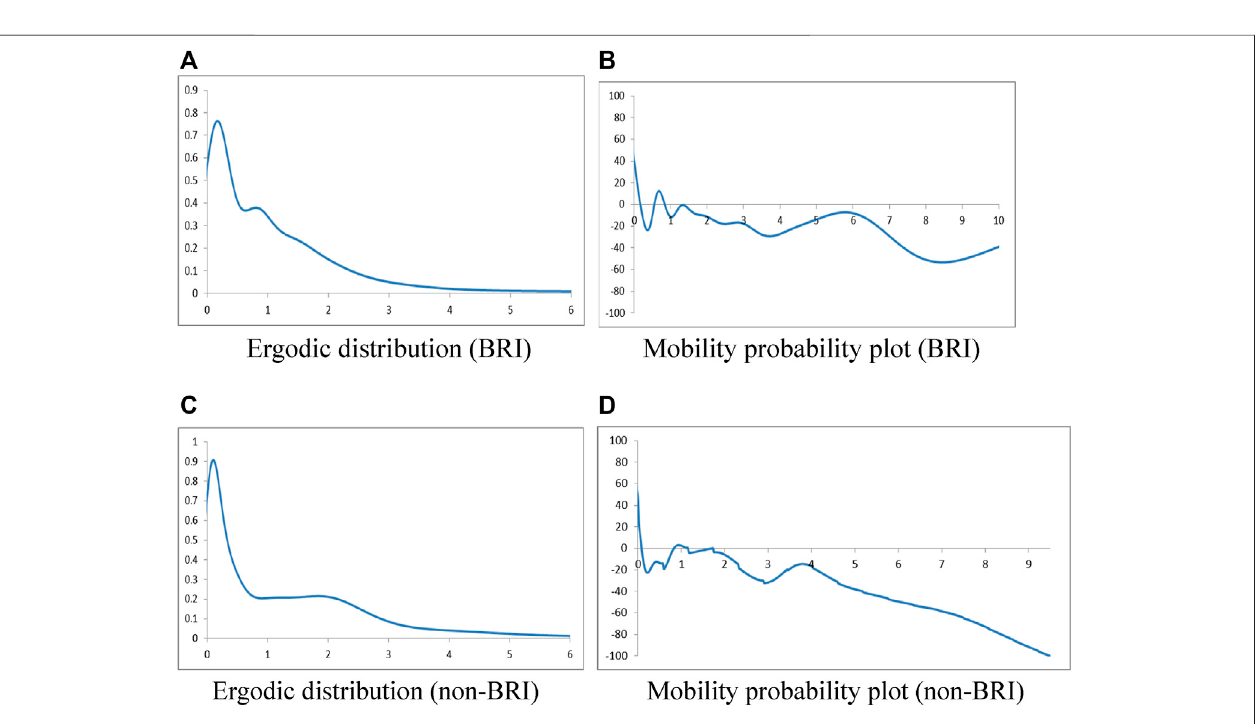
Frontiers in Environmental Science |